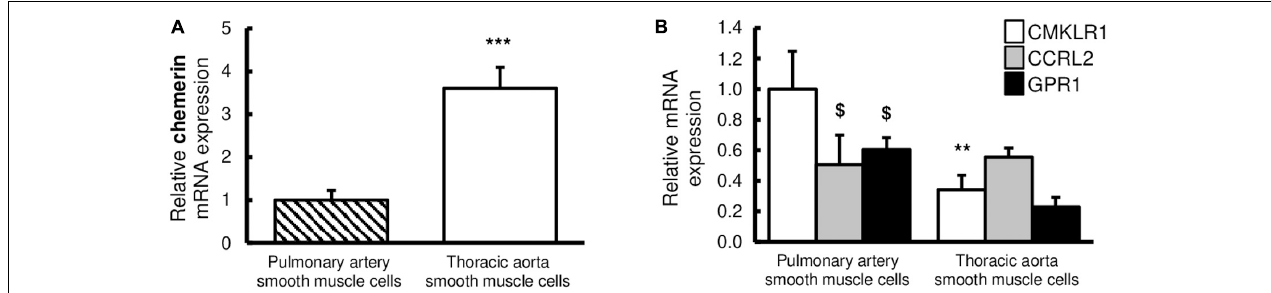
FIGURE 2 | Expressions of chemerin and its receptors in rat pulmonary artery and thoracic aorta. Relative gene expression of chemerin (A) and its three receptors (B) , the chemokine-like receptor 1 (CMKLR1 also called ChemR23; white bars), the C–C chemokine-like receptor 2 (CCRL2; gray bars), and the G protein-coupled receptor 1 (GPR1; black bars) in primary cultured pulmonary artery (seven experiments in total) and thoracic aorta (eight experiments in total) smooth muscle cells isolated from Wistar rats ( n = 5). Quantification of relative gene expression was achieved by real-time quantitative polymerase chain reaction (RTq-PCR) using the Pfaffl method with normalization with the housekeeping genes, GAPDH and HPRT1. Results were expressed as relative fold increase over the mean value of relative mRNA expression of chemerin (A) and CMKLR1 (B) in pulmonary artery smooth muscle cells arbitrarily fixed to 1 and presented as mean ± SEM. **0.001 < p < 0.01, *** p < 0.001 compared to the expression of the same gene in pulmonary artery; $ 0.01 < p < 0.05 compared to the gene expression of CMKLR1 in the same type of vessel.